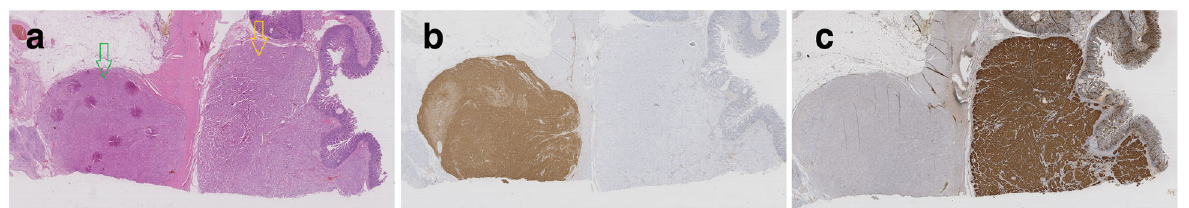
Fig. 3 a Histopathology - GIST (green arrow) and NET (yellow arrow), HE staining, 10x. b Histopathology - diffuse positivity of GIST, negativity of NET, CD117 (c-kit), 10x. c Histopathology - GIST negative, NET diffusely positive, chromogranin, 10x